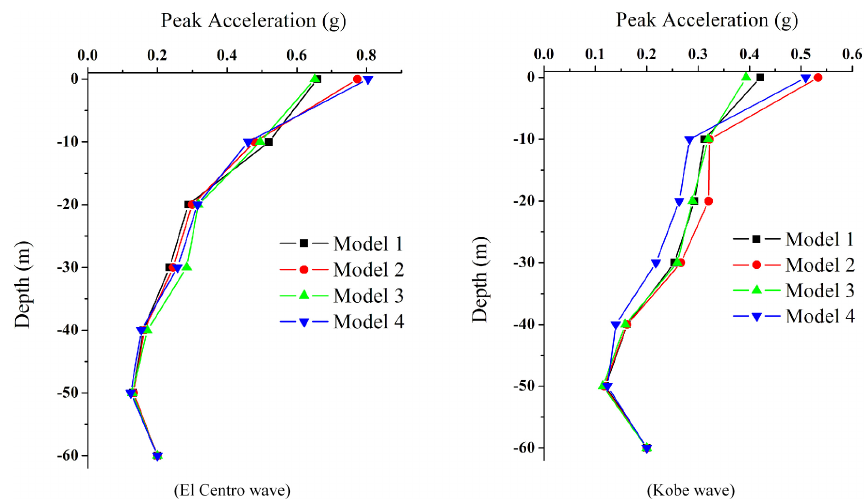
Figure 7. Variation of peak acceleration with depth under SV-wave input.